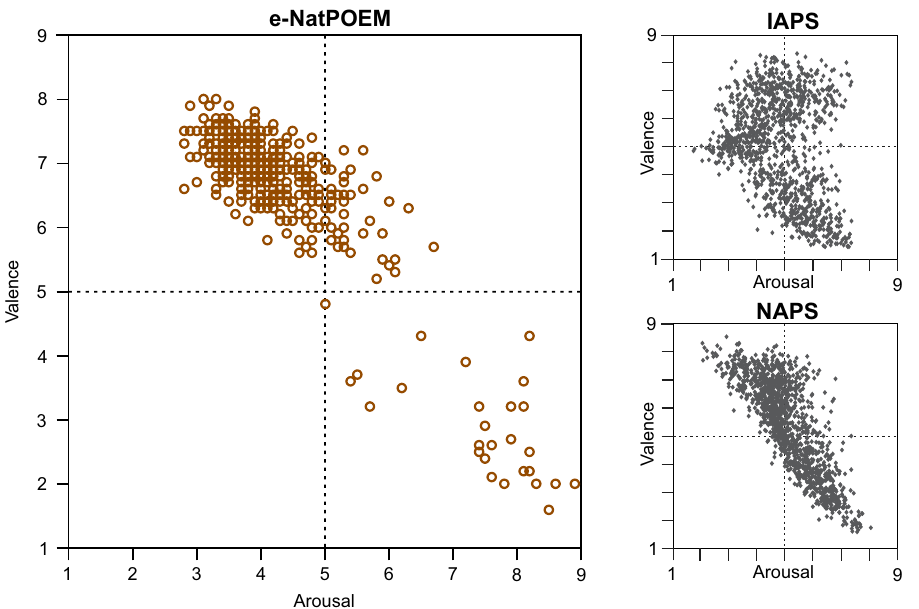
Figure 3. Affective space of the e-NatPOEM (including control images) with the estimated mean ratings of valence and arousal for each image. The affective spaces of the IAPS and NAPS databases are also presented, for comparison.